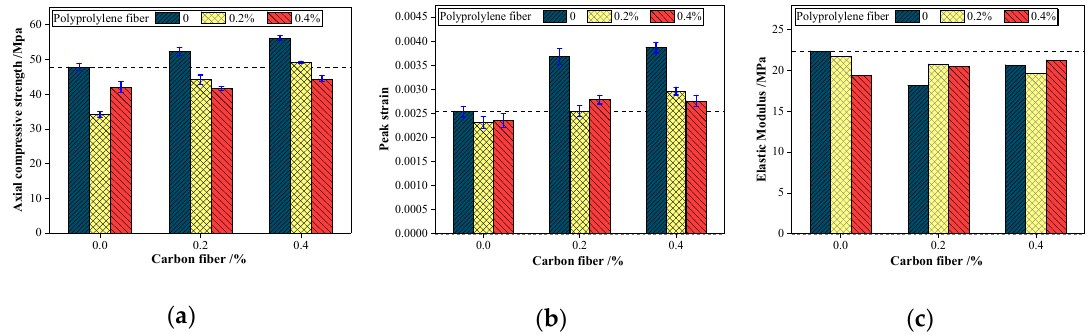
Figure 13. Stress–strain characteristic values for LWAC reinforced with carbon and / or polypropylene fiber: ( a ) axial compressive strength; ( b ) peak strain; ( c ) elastic modulus.